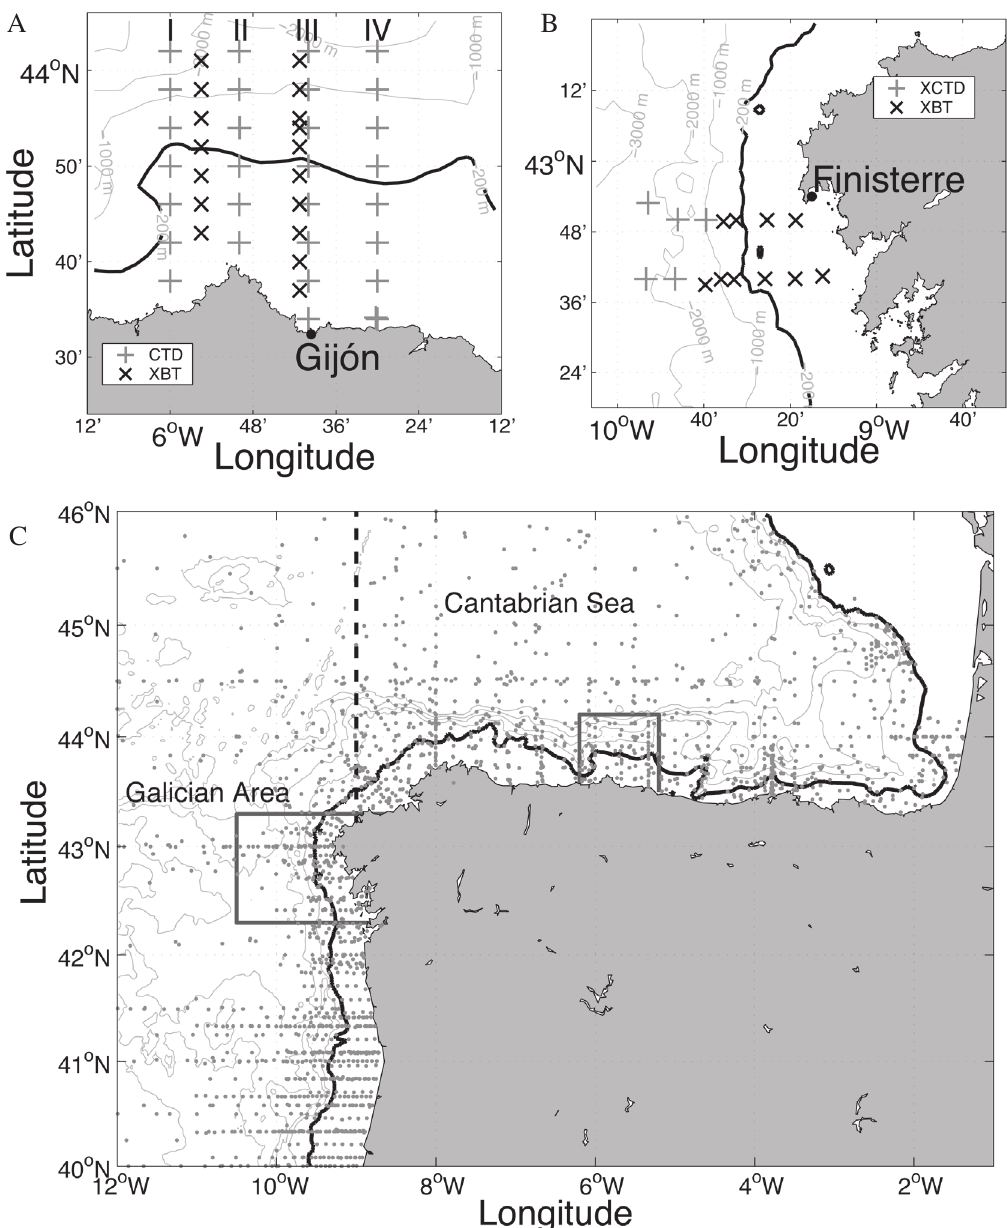
Fig . 2. – Oceanographic cruises during GIJON-2006 (A) and FINISTERRE-2006 (B) exercises. Sampling with XBTs, CTDs and XCTDs is indicated. Spatial distribution of the Hydrobase dataset in the region of interest (C). Exercise locations are bounded by a gray box. The thick solid line marks the isobath corresponding to 200 m. The meridional dashed line indicates the boundary between Galician Area and Cantabrian